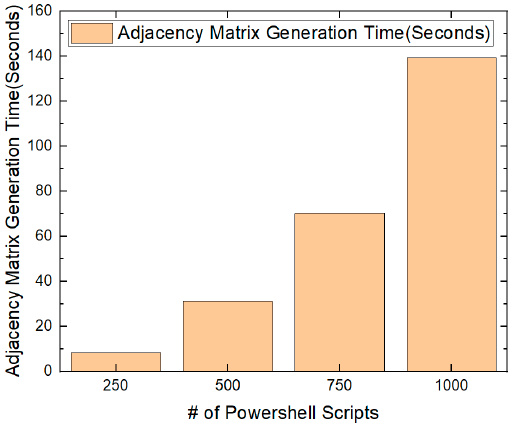
Figure 11. Adjacency matrix generation time.